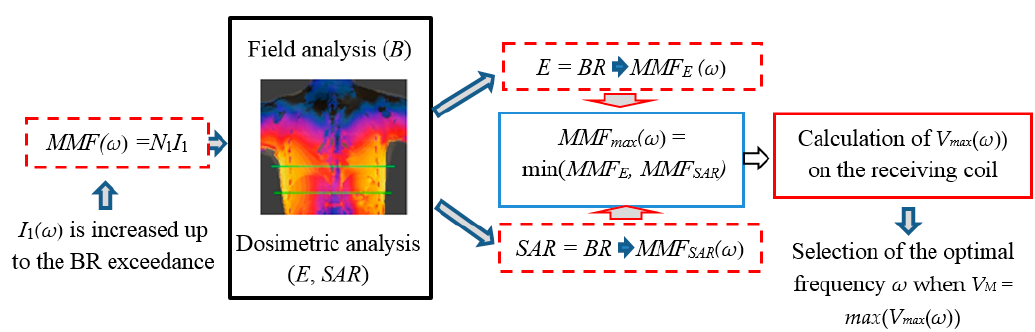
Figure 3. Scheme of the optimal frequency selection procedure.